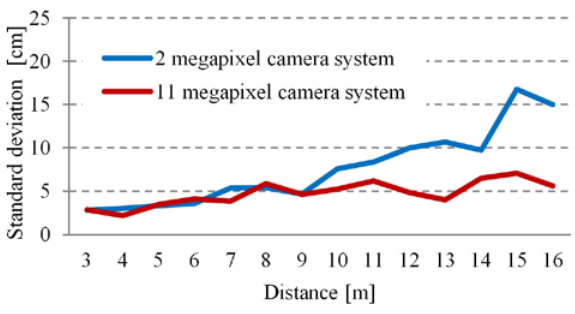
Figure 6. 3d point accuracy depending on measuring distance 3.3.2